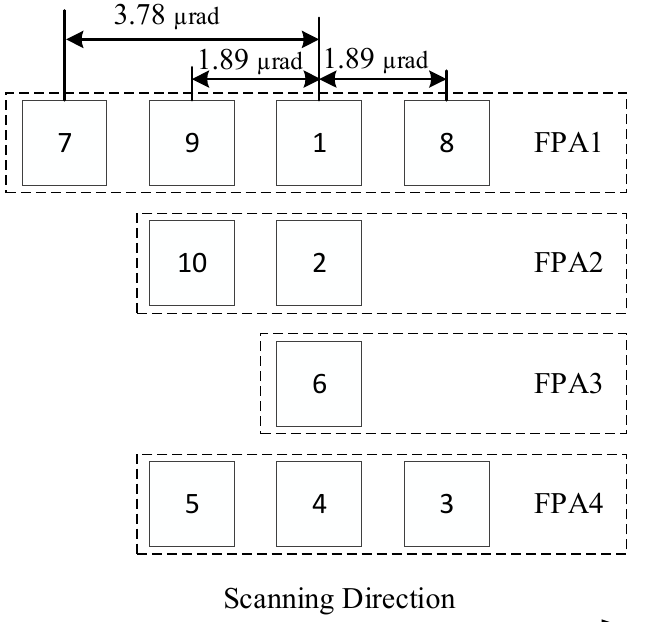
Figure 1. Ideal layout of VIRR FPAs configuration.